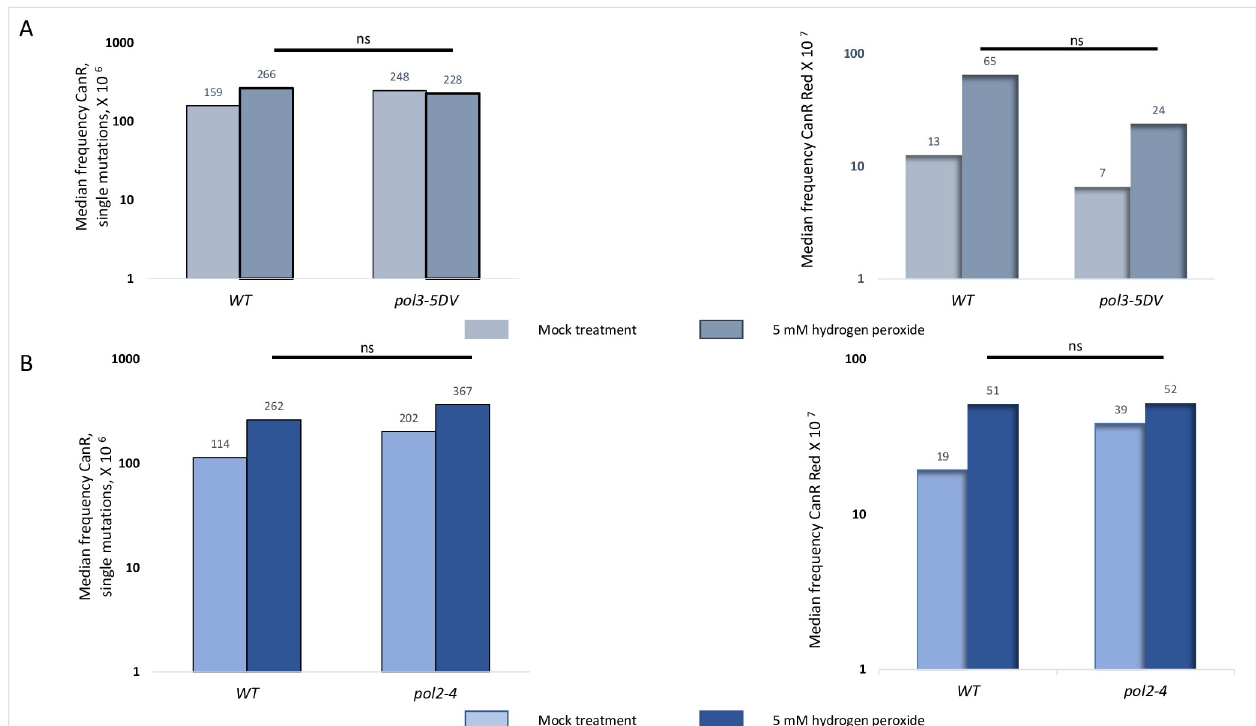
Fig 3. Hydrogen peroxide–induced mutagenesis is not caused by increased rates of incorporation errors by DNA polymerases delta and epsilon. A. Frequency of spontaneous and peroxide-induced CanR mutations and CanR Red closely spaced mutations in ssDNA triple reporter in parental wild-type and derivate pol3-5DV strains had been measured simultaneously for four ( wt ) and 24 ( pol3-5DV ) independent cultures, as described in Materials and methods. P values were determined by the Mann–Whitney test. See also S1 Data. B. Frequency of spontaneous and peroxide-induced CanR mutations and CanR Red closely spaced mutations in ssDNA triple reporter in parental wild-type and derivate pol2-4 strains had been measured simultaneously for eight ( wt ) and eight ( pol2-4 ) independent cultures, as described in Materials and methods. P values were determined by the Mann–Whitney test. See also S1 Data. CanR Red, canavanine-resistant red; ssDNA, single-strand DNA; wt,